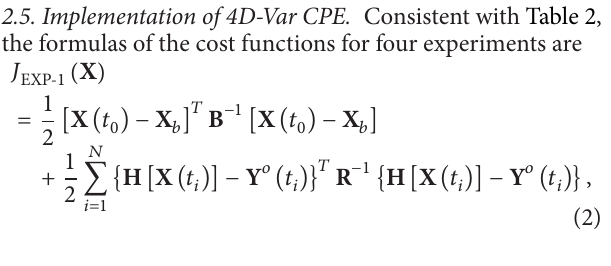
𝑂 𝑐 𝑑 and 1 are